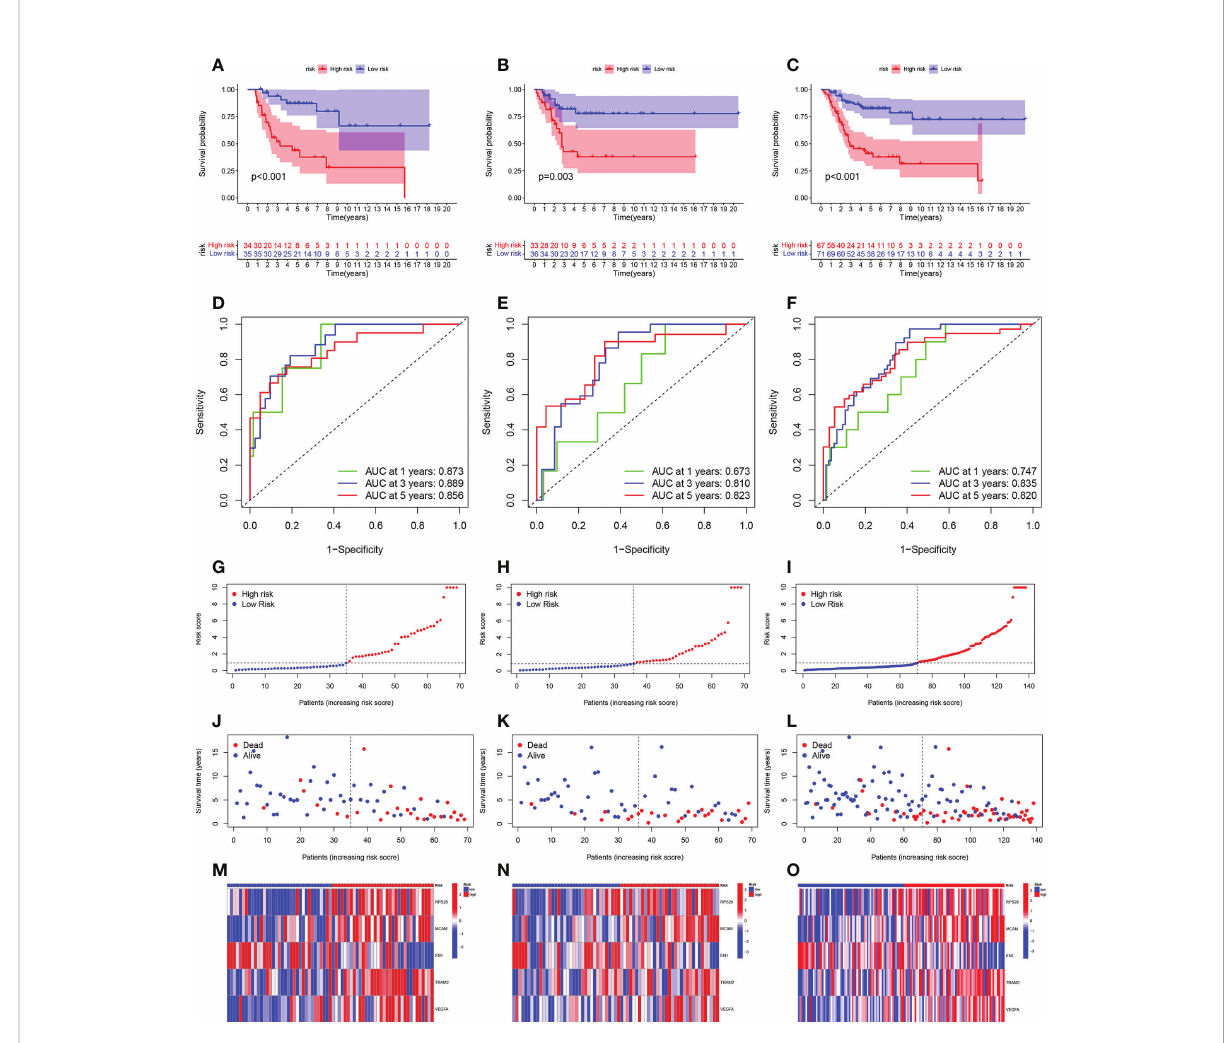
FIGURE 5 Prognostic value of the GCSRGs signature in training cohort, veri fi cation cohort and total cohort. (A – C) Kaplan-Meier survival curves according to risk score in the training cohort (A) , veri fi cation cohort (B) , and total cohort (C) . (D – F) ROC curves for predicting overall survival in the training cohort (D) , veri fi cation cohort (E) , and total cohort (F) . (G – I) Distribution of risk score in the high-risk group and the low-risk group in the training cohort (G) , veri fi cation cohort (H) , and total cohort (I – L) Survival status between the high-risk group and the low-risk group in the training cohort (J) , veri fi cation cohort (K) , and total cohort (L-O) .Heatmap of the expression pro fi le of the included glycolysis-cholesterol synthesis related genes in the training cohort (M) , veri fi cation cohort (N) , and total cohort (O)